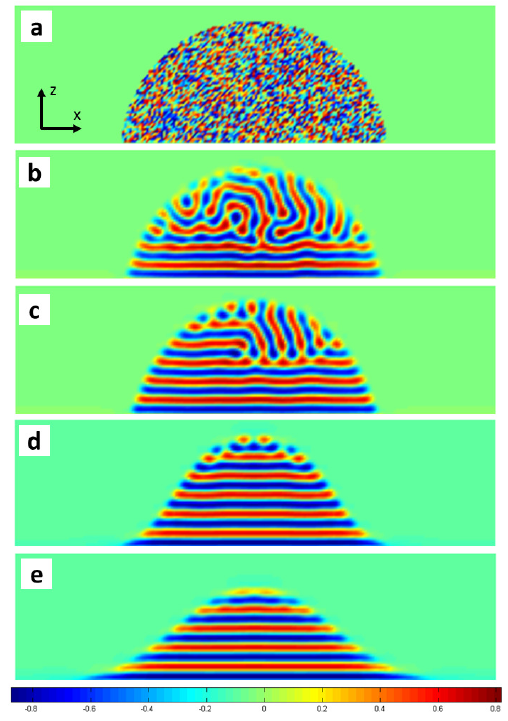
Figure 6: Time evolution of copolymer nano-drops on a rigid substrate. The composition of the copolymer is shown in the x , z plane. Simulation data: system with a 512x512x256 grid with ∆ x = 0 . 3 , ∆ t = 1 . 5 and periodic boundary conditions in the x and y di- rections and no flow in the z direction. c 2 = 0 . 1 , u 2 = 1 , D 2 = 1 , α = 1 , φ = 0 was used for the copolymer. For this set of parameters the structure corresponds to a lamellae structure. c 1 = 0 . 3 , u 1 = 1 , D 1 = 0 . 5 was used for the solvent. The interaction parameters were b 1 = 0 . 03 , b 2 = 0 . 3 , b 3 = 0 , b 4 = 0 . 1. Times: (a) t = 0, (b) t = 1000, (c) t = 10000, (d) t = 100000.